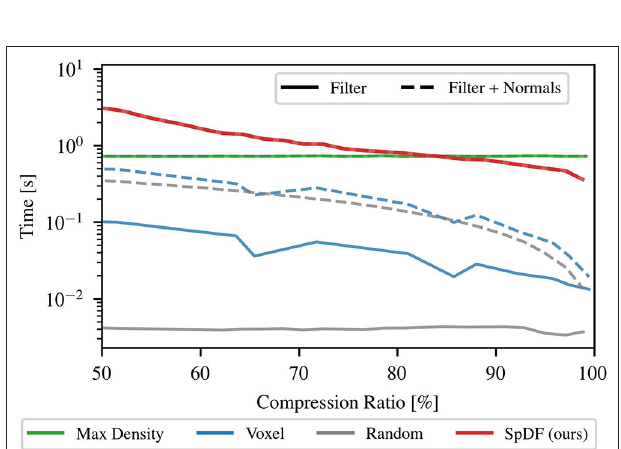
FIGURE 9 | Computation time analysis as function the compression ratio for Random , Voxel , MaxDensity , and SpDF (ours) sampling methods. The computation time of applying the filter (solid-line) has been measured along with the accumulated time required for normals estimations (dashed-line). For MaxDensity and Random , the computation time of applying the filter is constant with respect to the compression ratio. For Voxel and SpDF , it decreases while the compression ratio increases, as the number of cells decreases and the number of iterations for the voting process also